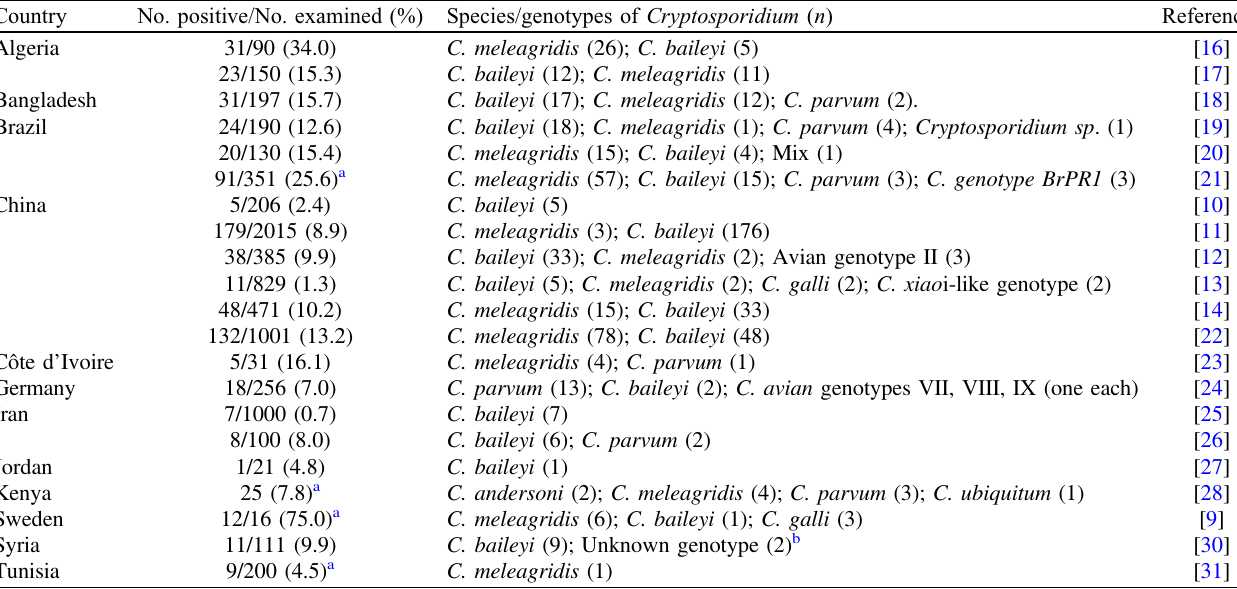
Table 3. Prevalence and species/genotype distribution of Cryptosporidium in chickens worldwide. Country